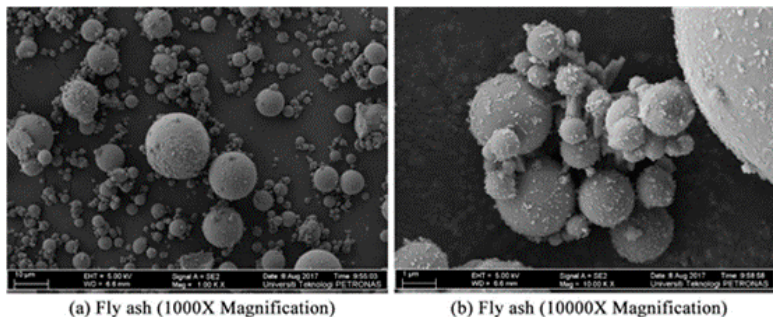
Figure 4. SEM micrograph of fly ash samples.